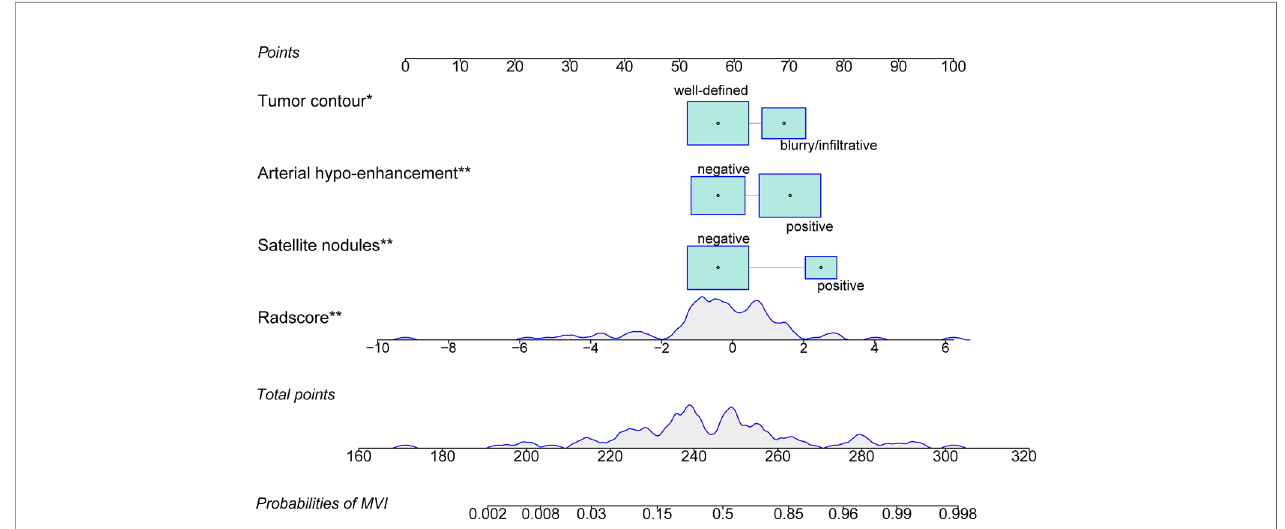
FIGURE 4 | The radiomics nomogram was developed by incorporating the portal phase image radiomics signature, satellite nodules, arterial hypo-enhancement, and tumor contour. *p < 0.05; **p < 0.01.